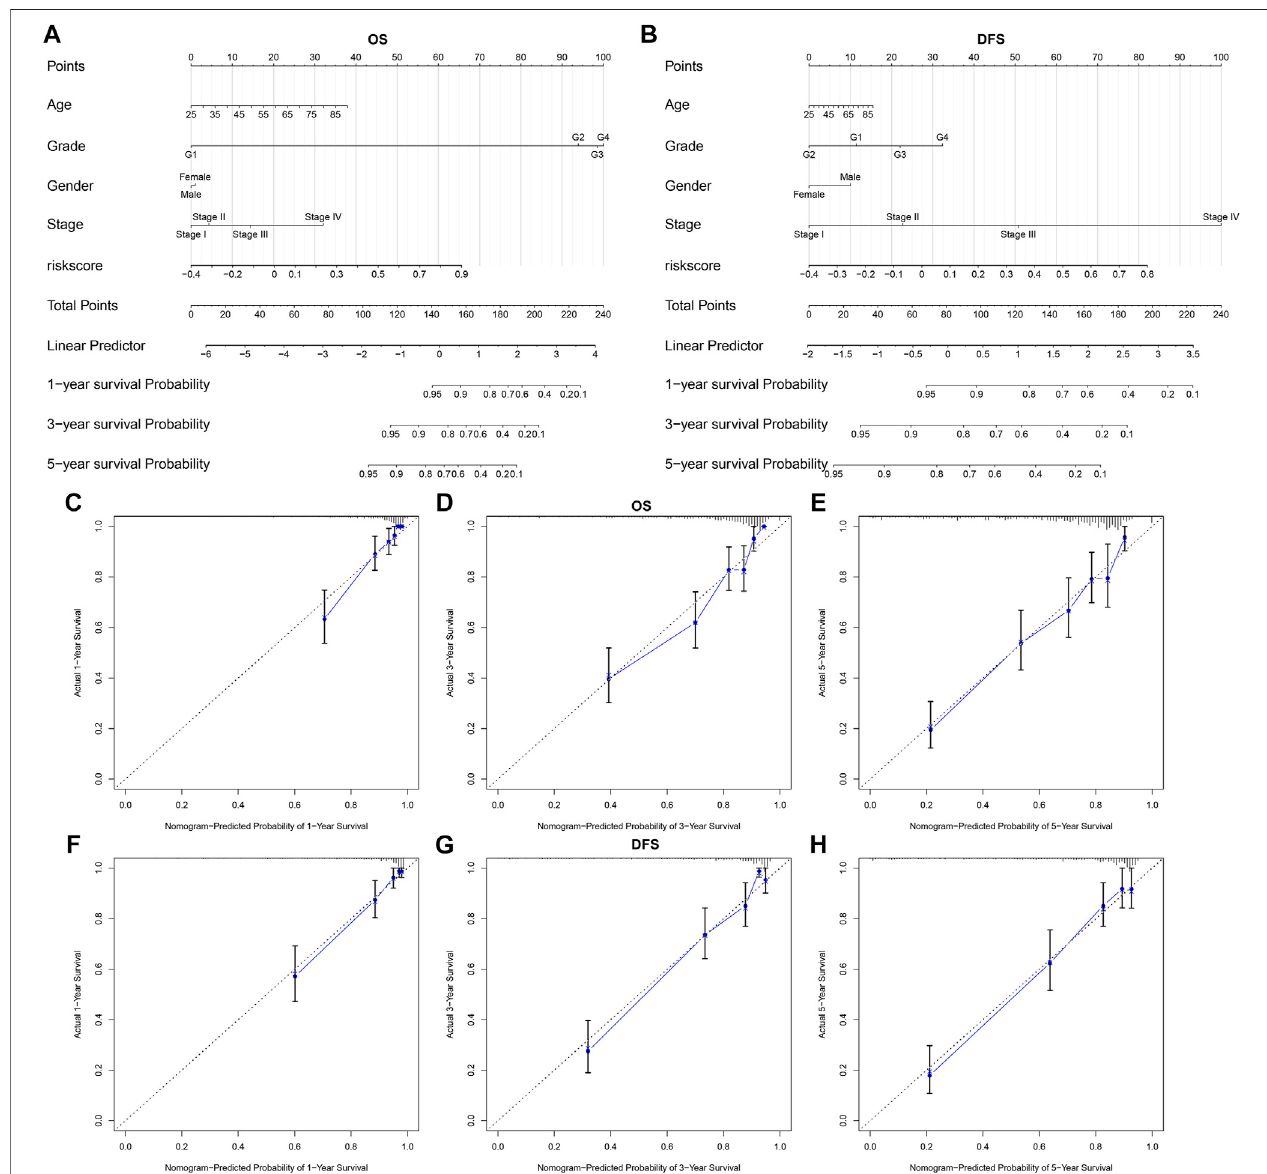
FIGURE 8 | A nomogram incorporating subtype-speci fi c signature and clinical factors improves predictive ef fi cacy for ccRCC prognosis (A, B) Construction of a nomogramcombining thesubtype-speci fi csignatureand clinical features for prediction ofOSand DFS.Calibrationplots displayed the actual and nomogram-predicted probability of one-, three- and fi ve-years OS (C – E) and DFS (F – H) .